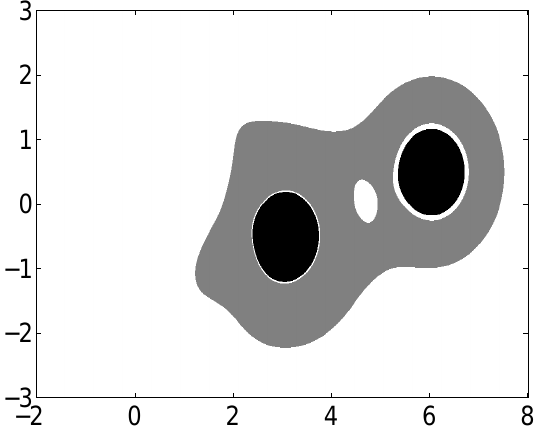
Fig. 7. Spatially averaged abundance of the phytoplankton groups in the complete region of vortices (exterior and interior). Note the different periodicity of the two phytoplankton groups. bution of dominance patterns. The composition of the phytoplankton community is different for the two different vortices. The phytoplankton group better adapted to a high nutrient availability 275 only occurs in every lower vortex. Furthermore, it just occurs in a small ring in the exterior of the vortex. Therefore, the question arises which mechanism is responsible for the distinctly different spatio-temporal distributions of the competing plankton groups. 13